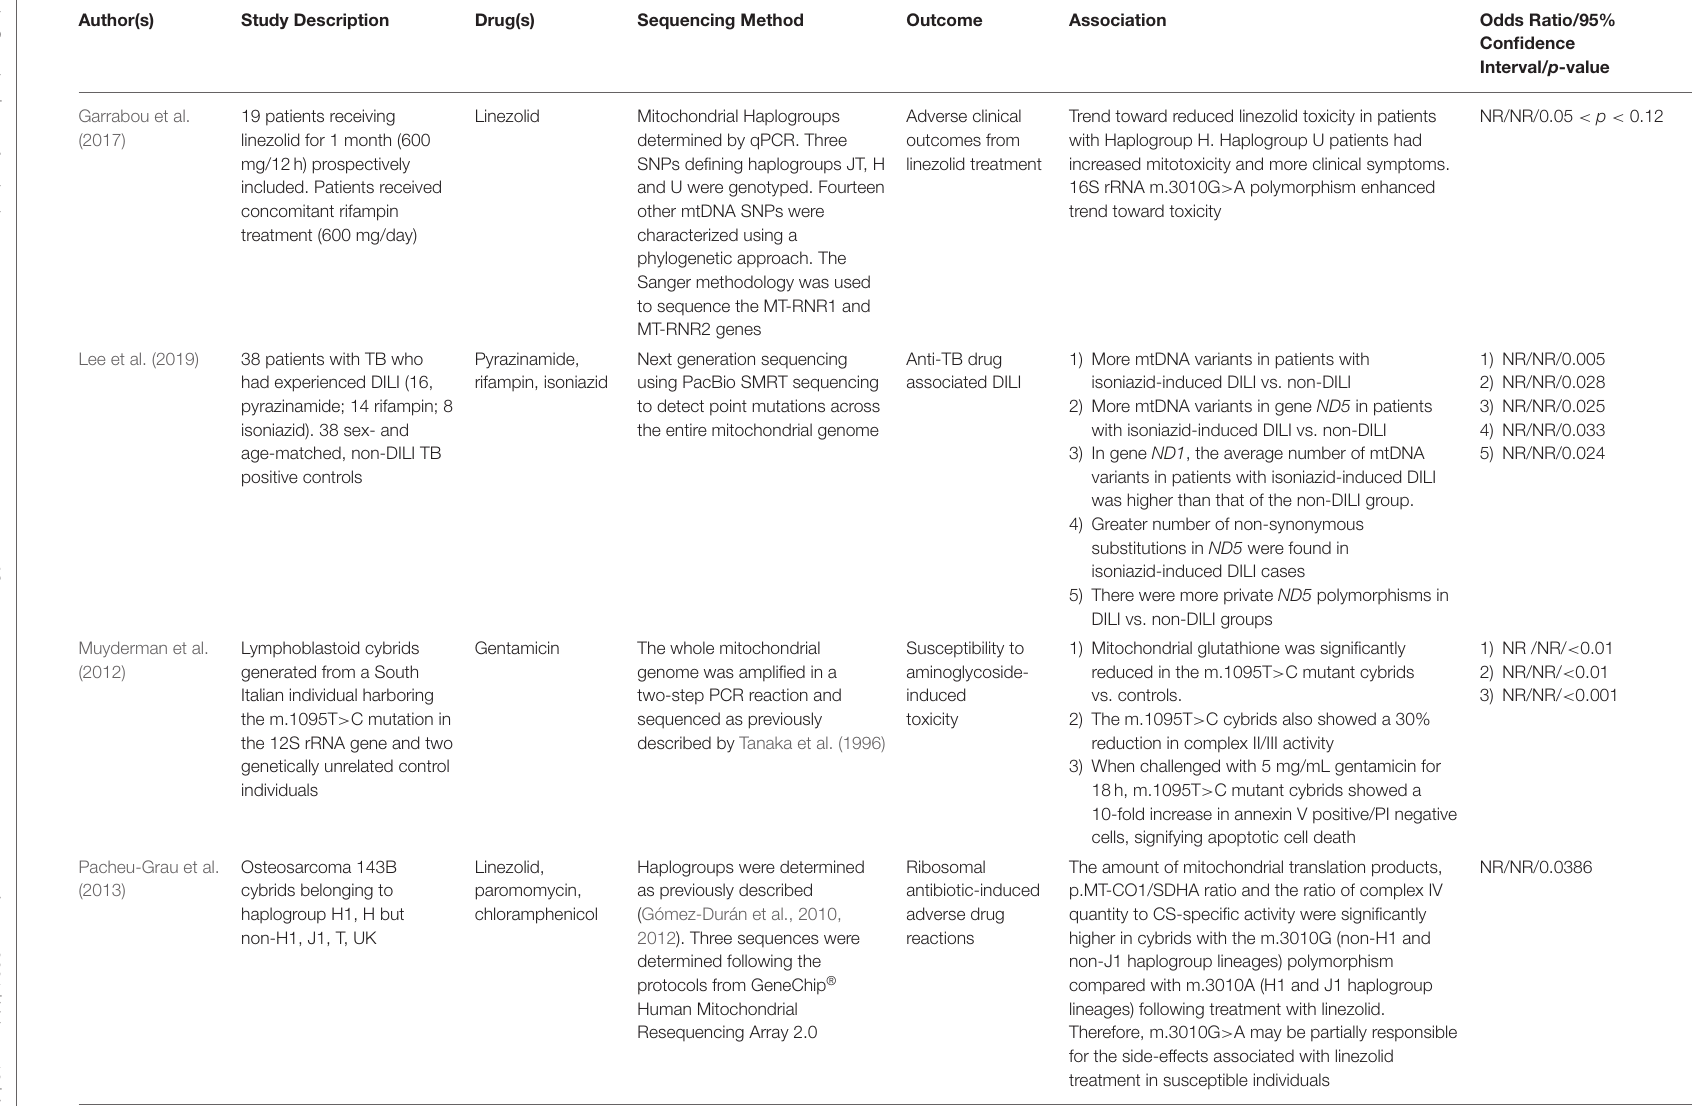
Abstraction table details the author(s), study design, drug(s) of interest, sequencing methods, outcomes, associations and statistics. CS, citrate synthase; cybrids, cytoplasmic hybrids; DILI, drug-induced liver injury; MT-COI, mitochondrially encoded cytochrome c oxidase subunit 1; NR, not reported; qPCR, quantitative polymerase chain reaction; rRNA, ribosomal RNA; SDHA, succinate dehydrogenase subunit A; SMRT, Single Molecule, Real-Time; SNP, single nucleotide polymorphisms; TB,